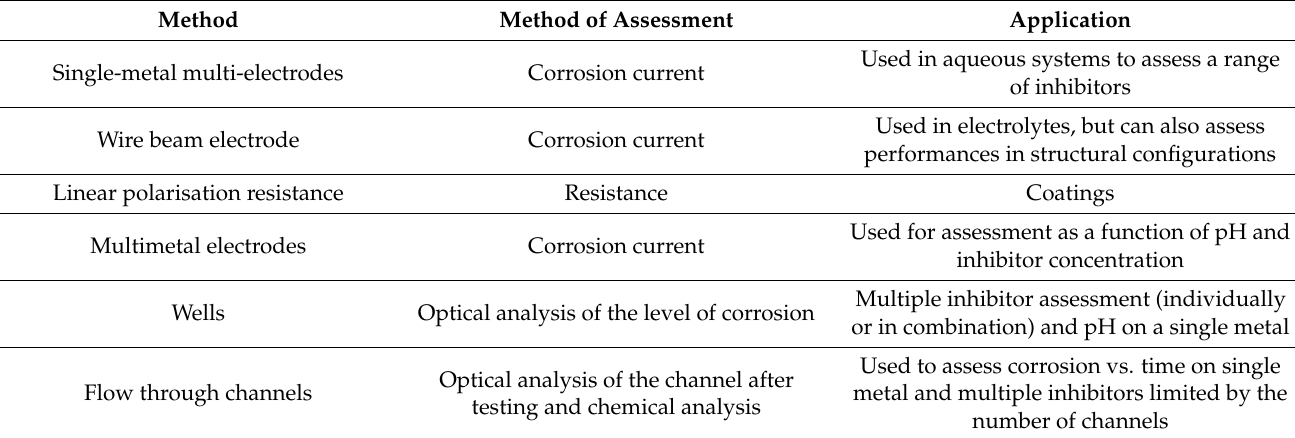
Table 1. Types of high-throughput experiments and the method of